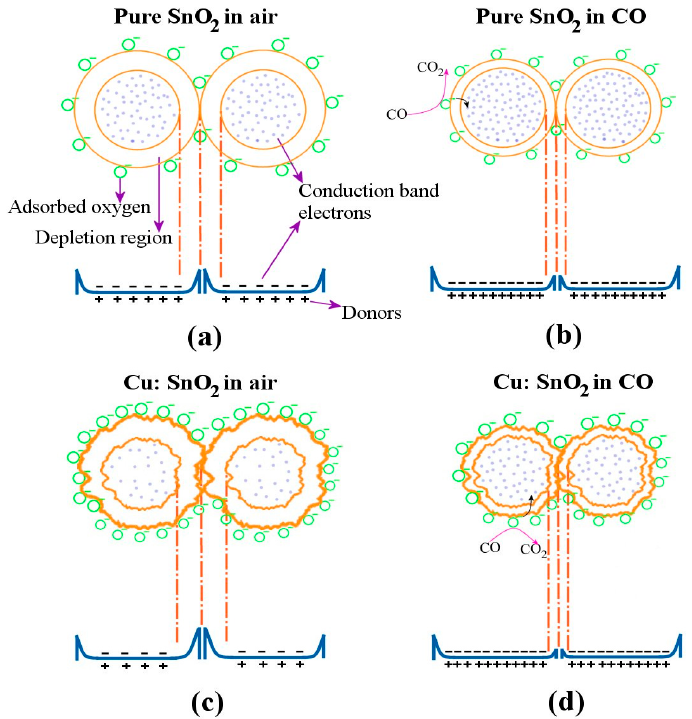
Figure 9. Gas-sensing mechanism of the pure SnO 2 in ( a ) air and ( b ) CO; and Cu:SnO 2 pellets in ( c ) air and ( d )